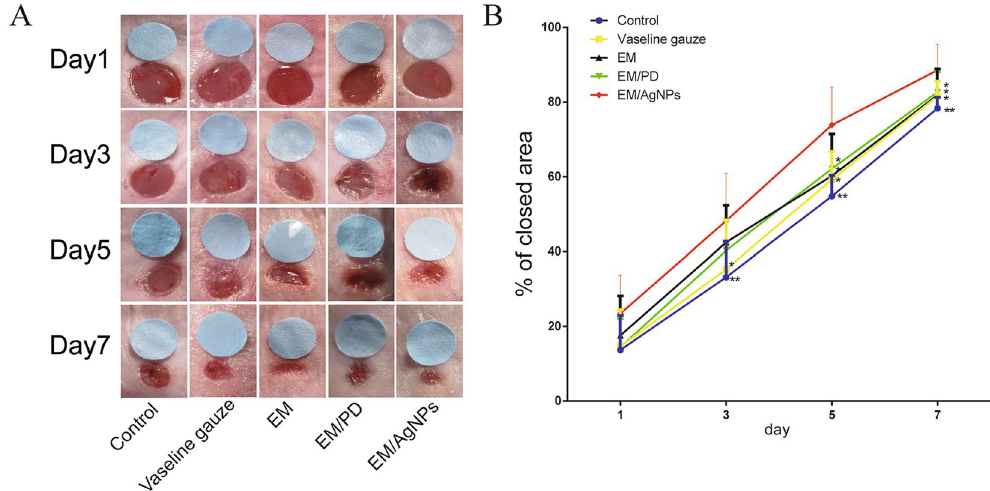
Figure 8. The effect of EM/AgNPs on wound healing. ( A ) The representative macroscopic appearance of wounds from the control, Vaseline gauze, EM, EM/PD and EM/AgNPs groups. ( B ) The area of wound closure at different time points. The values are shown as the mean ± SD (n =